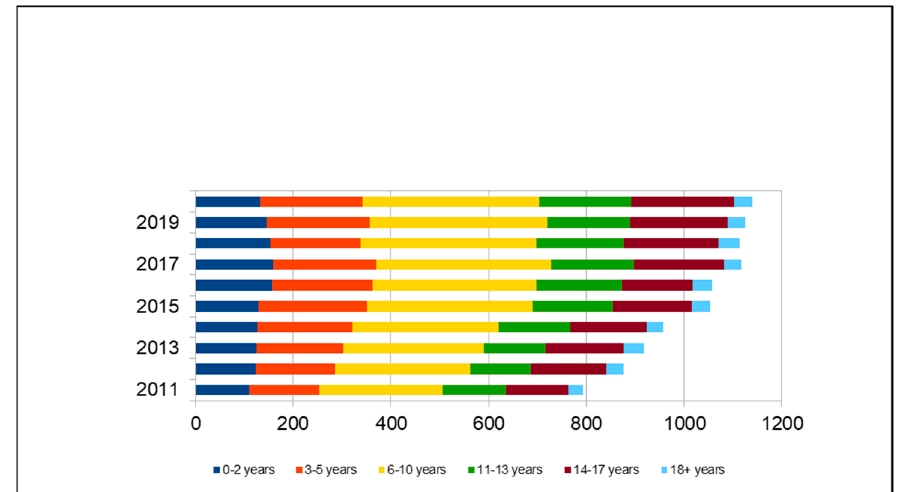
Table 2. Incidence of hearing loss by age in percentage.